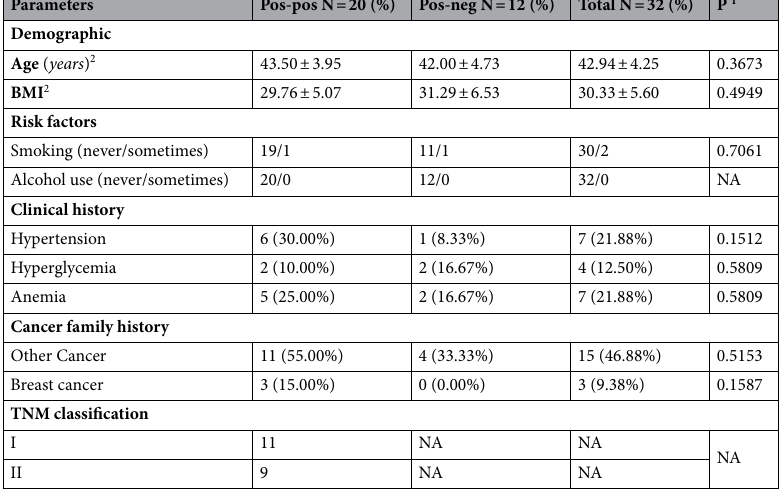
Table 1. Participants’ characteristics (Pos-pos and Pos-neg). Pos-neg Positive–negative subjects, Pos-pos Positive-positive subjects, BMI Body Mass Index, TNM Tumor, Nodes, Metastases according to Cancer ( AJCC American Joint Committee on Cancer), NA Not Applicable. 1 Pearson chi square (categorical variables), Student t-test (continuous variables), Value in bold is statistically significant < 0.05. 2 Mean ± standard